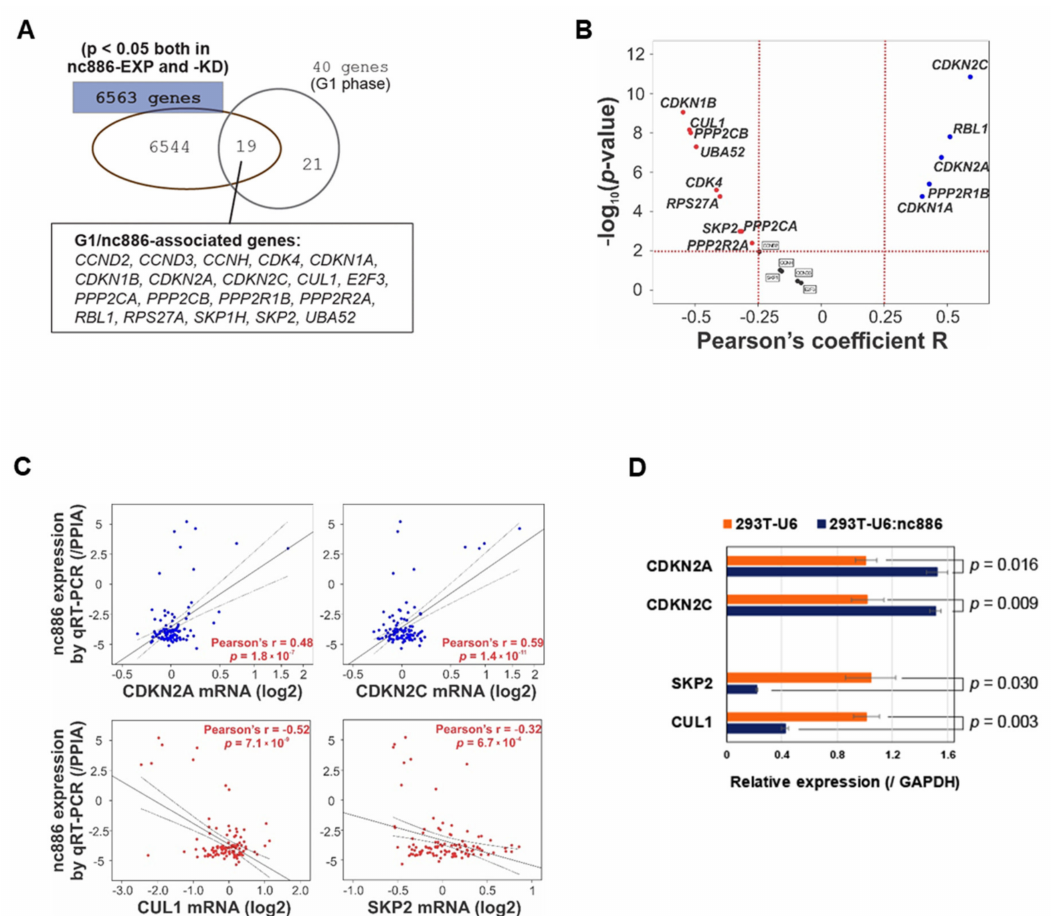
Figure 4. nc886 controls the expression of cell cycle genes. ( A ) Venn diagram of cell cycle genes (40 genes) and significantly altered genes by nc886 (6563 genes). ( B ) Volcano map of 19 nc886 / G1-associated genes to show the statistical correlation with nc886 expression in the 108 esophageal squamous cell carcinoma (ESCC) patient cohort. ( C ) Correlation analysis between nc886 expression and representative cell cycle genes. ( D ) qRT-PCR of indicated genes. Mean values from triplicate samples are shown in a bar graph with standard errors and p -value